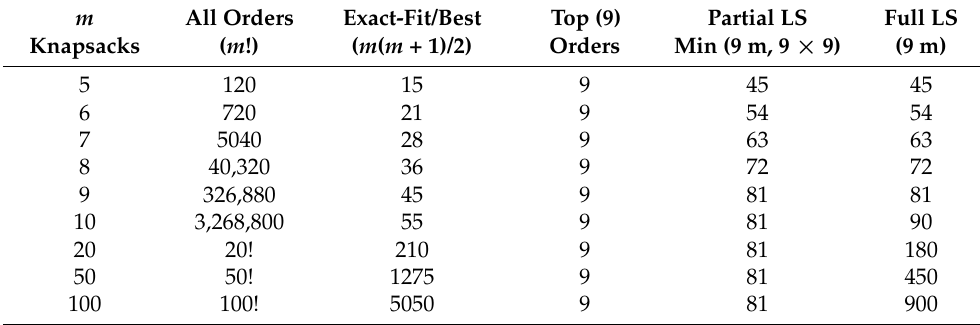
Figure 18. An example of increasing C i (an effective knapsack order) for the 0/1-mKP. Table 1. All possible ( m !) knapsack orders and the proposed effective orders for the